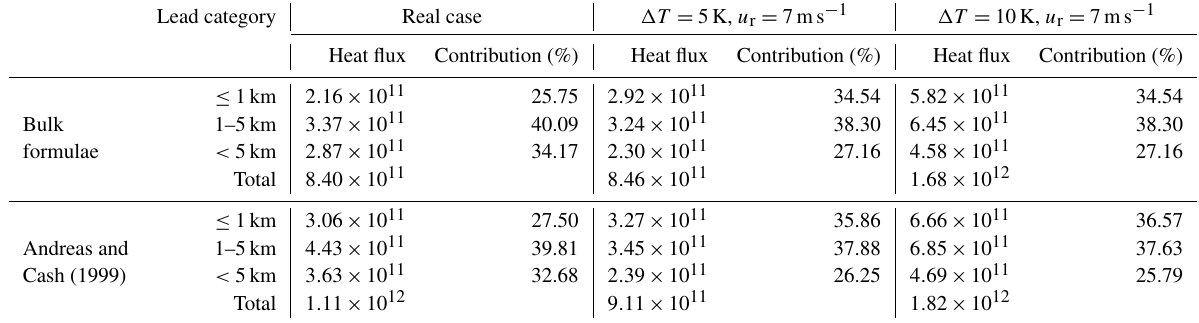
Table 5. Turbulent heat flux ( W ) for higher temperature differences using Landsat-8 TIRS data and the Andreas and Cash (1999) model. Lead category Real